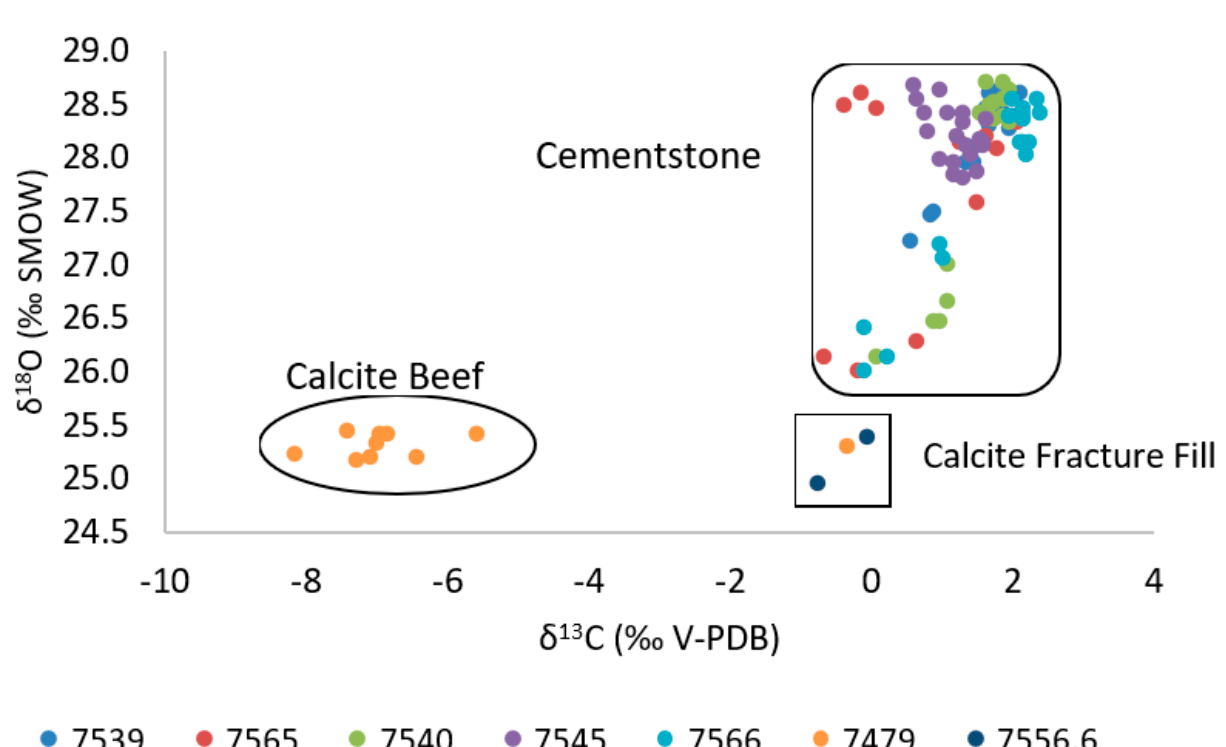
Figure 10. δ 13 C versus δ 18 O values for all cemented grid and calcite fracture samples [59].